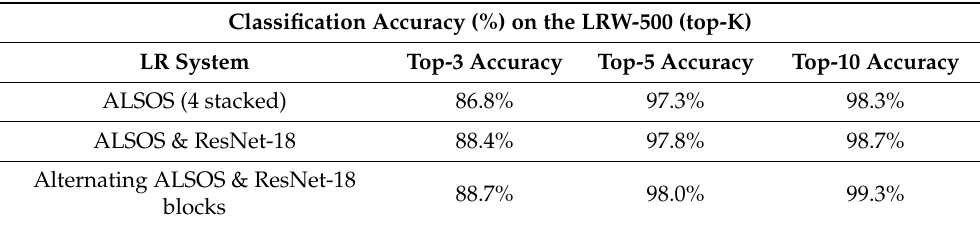
Table 5. Classification top-3, top-5, and top-10 accuracies (%) on the LRW-500